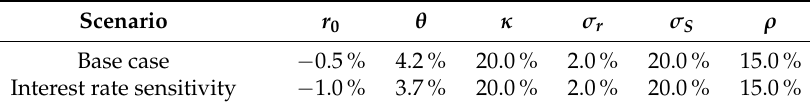
Table 6. Financial market